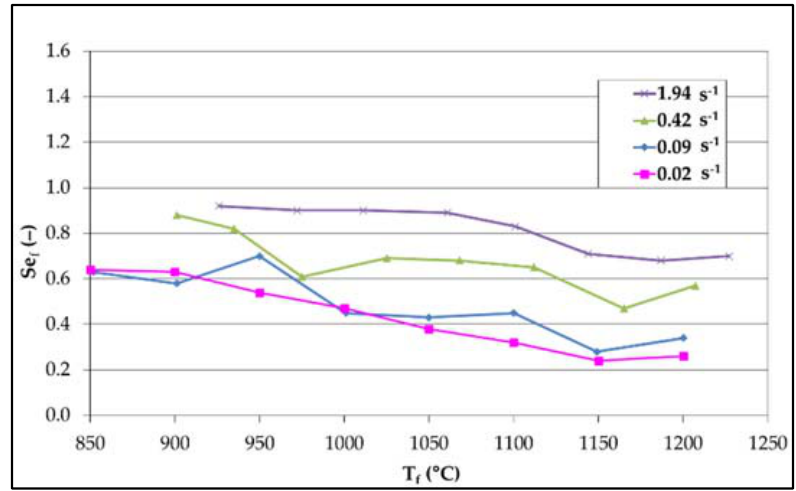
Figure 3. Dependence of the fracture strain intensity ( Se f ) on the test temperature ( T f ), and strain rate, 0.12 wt.% Bi.